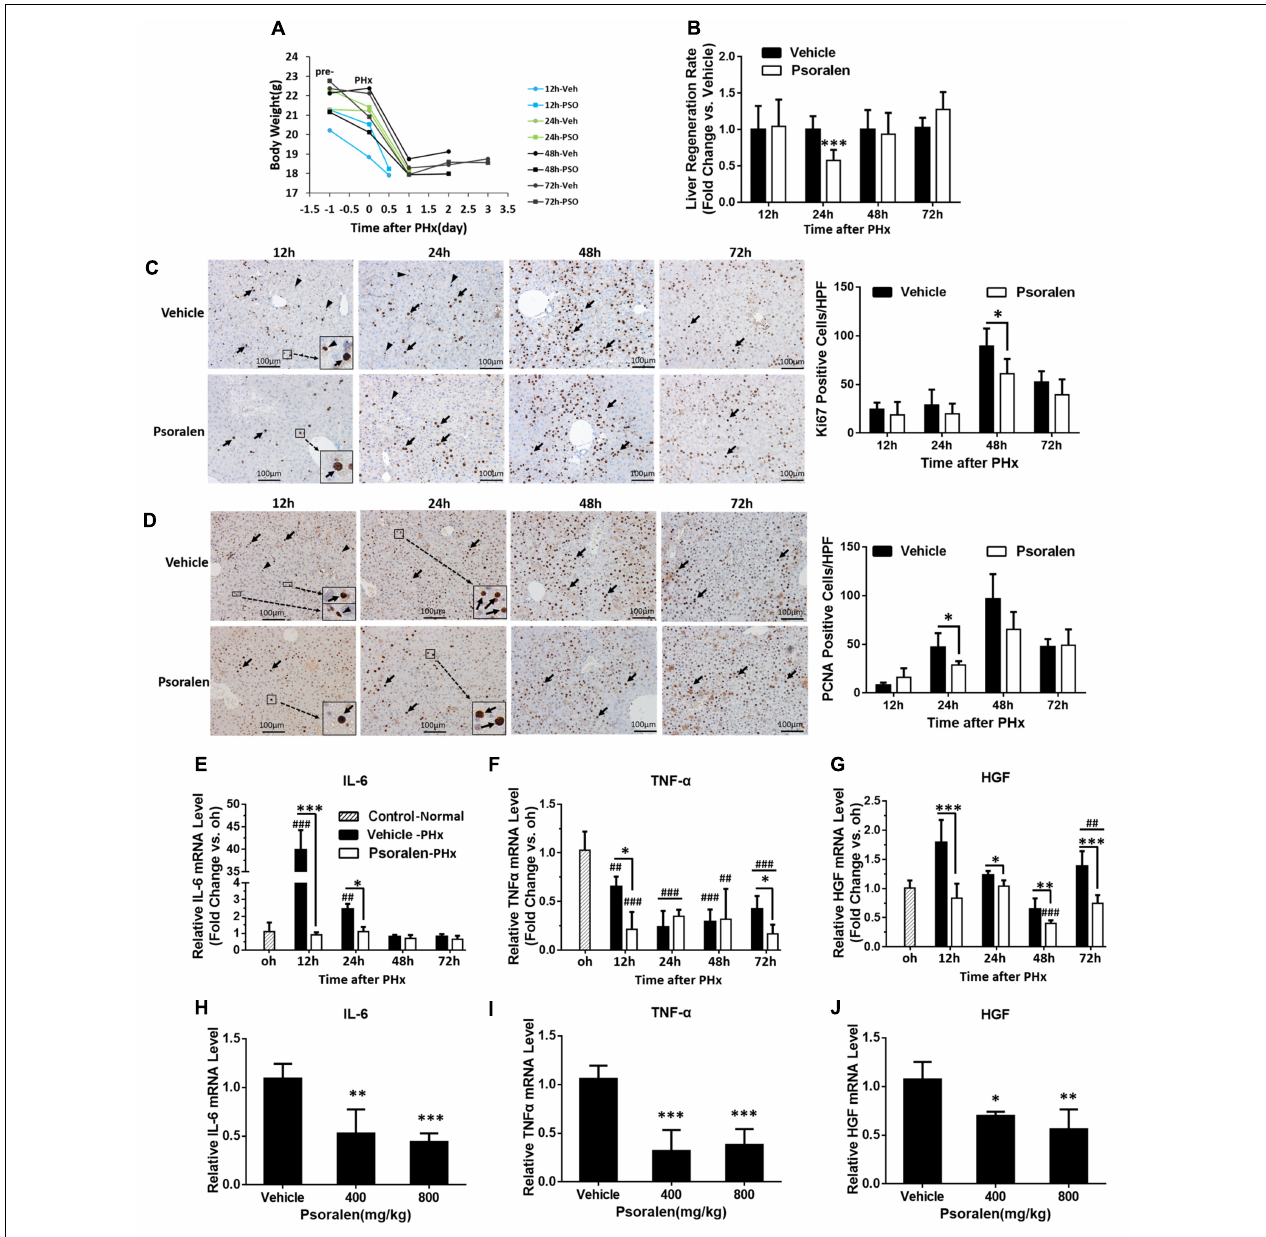
FIGURE 5 | Psoralen delayed liver regeneration in PHx mice. C57BL/6 mice were subjected to PHx and treated with 200 mg/kg of psoralen or 0.5% CMC-Na. (A) Changes in body weight over time in PHx mice treated with CMC-Na or psoralen. (B) Relative liver regeneration ratio in PHx mice treated with CMC-Na or psoralen. (C,D) Liver sections for the evaluation of hepatocyte proliferation with anti-Ki67 (C) and anti-PCNA (D) staining, original magnification, 200 × . Left panel: representative immunohistochemical images, proliferative hepatocytes (black arrow) or inflammatory cells (black arrowhead) are shown; right panel: number of Ki67- or PCNA-positive hepatocytes/high-power field (HPF). Ten random HPF views were counted in liver sections of each mouse. (E–G) Hepatic mRNA expression levels of IL-6 (E) , TNF- α (F) , and HGF (G) in PHx mice were determined using real-time qPCR. The relative mRNA levels were normalised to control mice (control group); β -actin was used as a reference gene. (H–J) Hepatic mRNA expression levels of IL-6 (H) , TNF- α (I) , and HGF (J) of normal mice treated with 400 mg/kg or 800 mg/kg of psoralen or CMC-Na. Data are means ± SDs ( n = 6–8). ∗ p < 0.05, ∗∗ p < 0.01, ∗∗∗ p < 0.001 versus the vehicle group; ## p < 0.01, ### p < 0.001 versus control